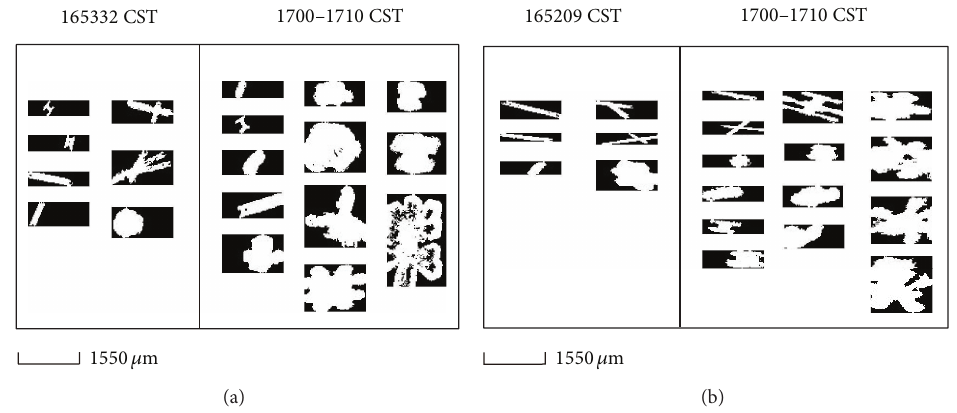
Figure 5: CIP images across flight legs (a) 2 and (b) 3 during selected periods.